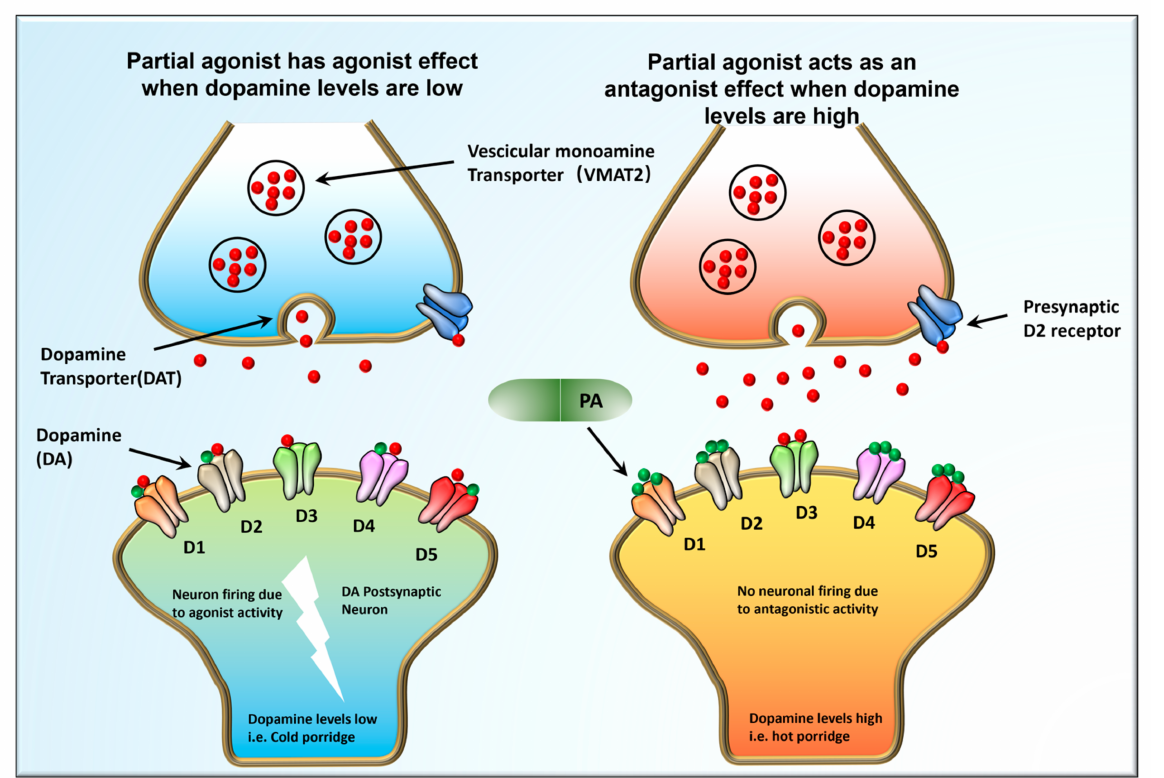
Figure 1. The Goldilocks effect. Dopaminergic signaling pathways in between neurons during impulse firing. Partial DA receptor inhibitors can adjust DA levels in individuals depending on the DA levels the body demands at that particular given time. ARP is an example of the partial D2 receptor that is used to mitigate both positive and negative symptoms of